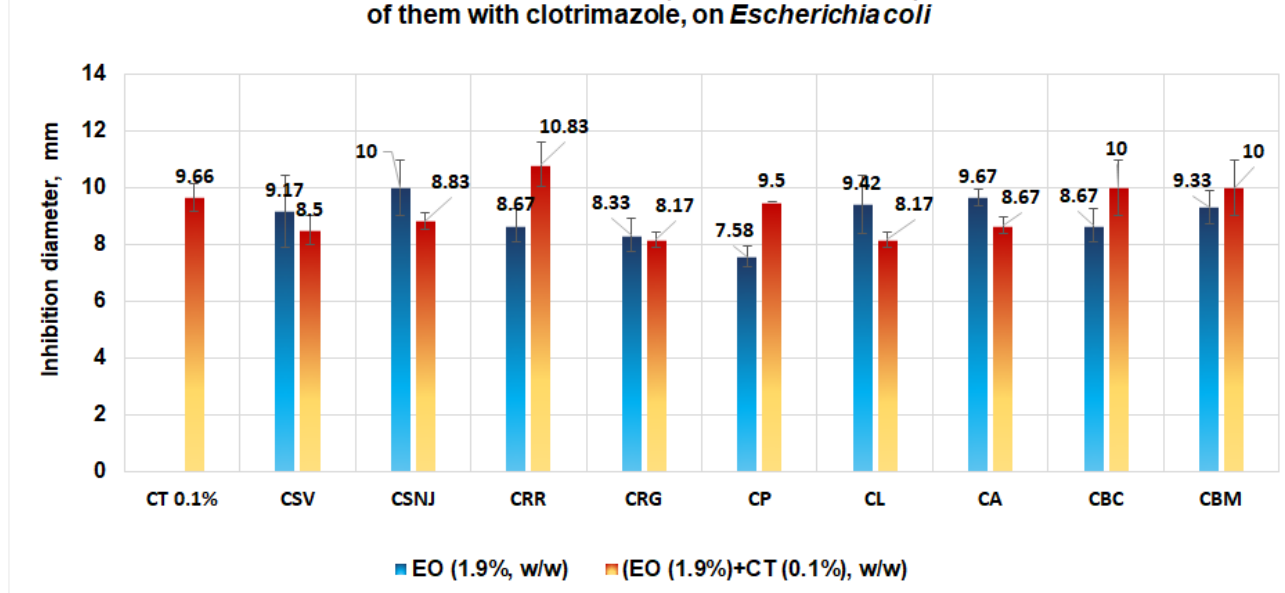
Figure 12. Influence of different sources of limonene (citrus essential oil, 1.9%, w/w) and of the mix- ture of them with clotrimazole (0.1%, w/w), on E.coli. No synergism between clotrimazole and the different sources of limonene was observed.